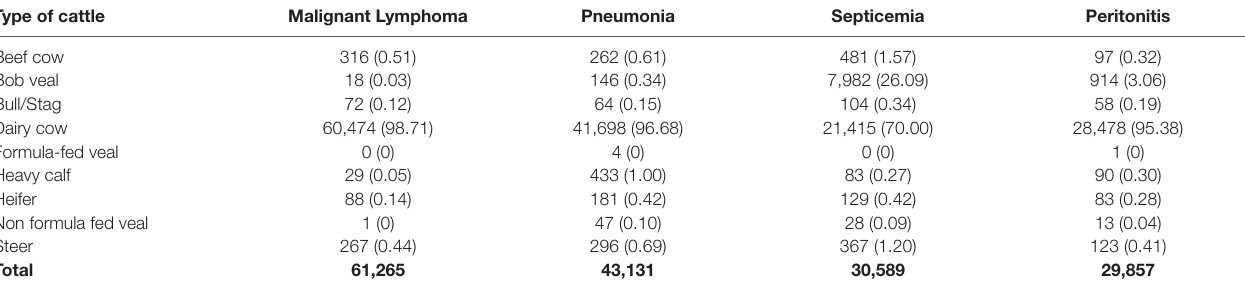
TaBle 1 | Number of malignant lymphoma, abscess/pyemia, emaciation and, epithelioma carcasses condemned in California from Jan-2005 to Dec-2014 by type of cattle. The percentage is presented in parentheses. Type of cattle Malignant